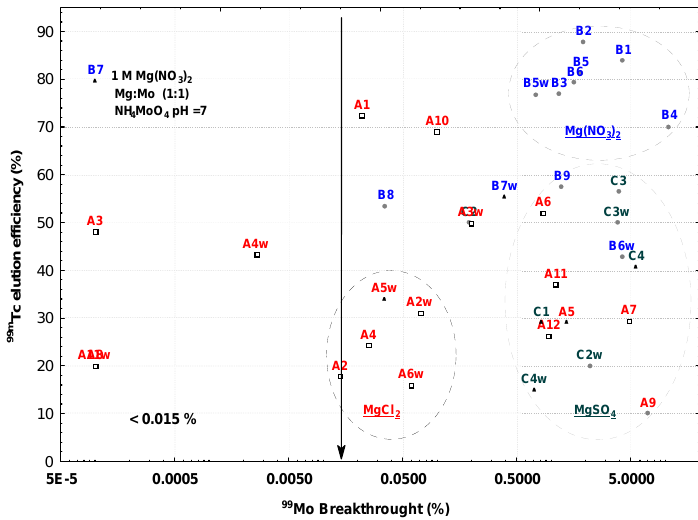
Figure 1. Distribution of magnesium 99 Mo-molybdate generator performances ( 99m